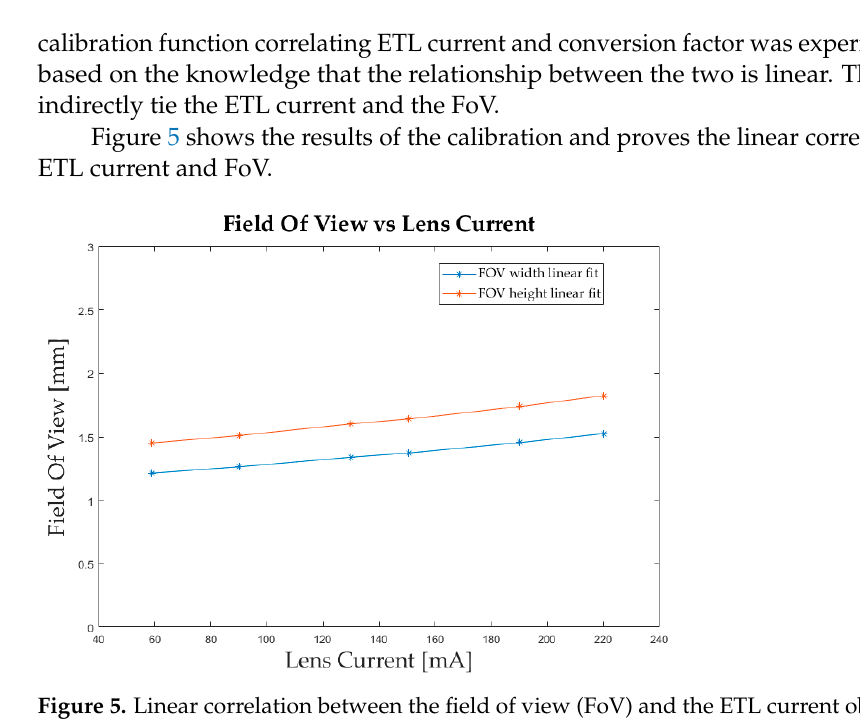
Figure 5. Linear correlation between the field of view (FoV) and the ETL current obtained through six calibration images.